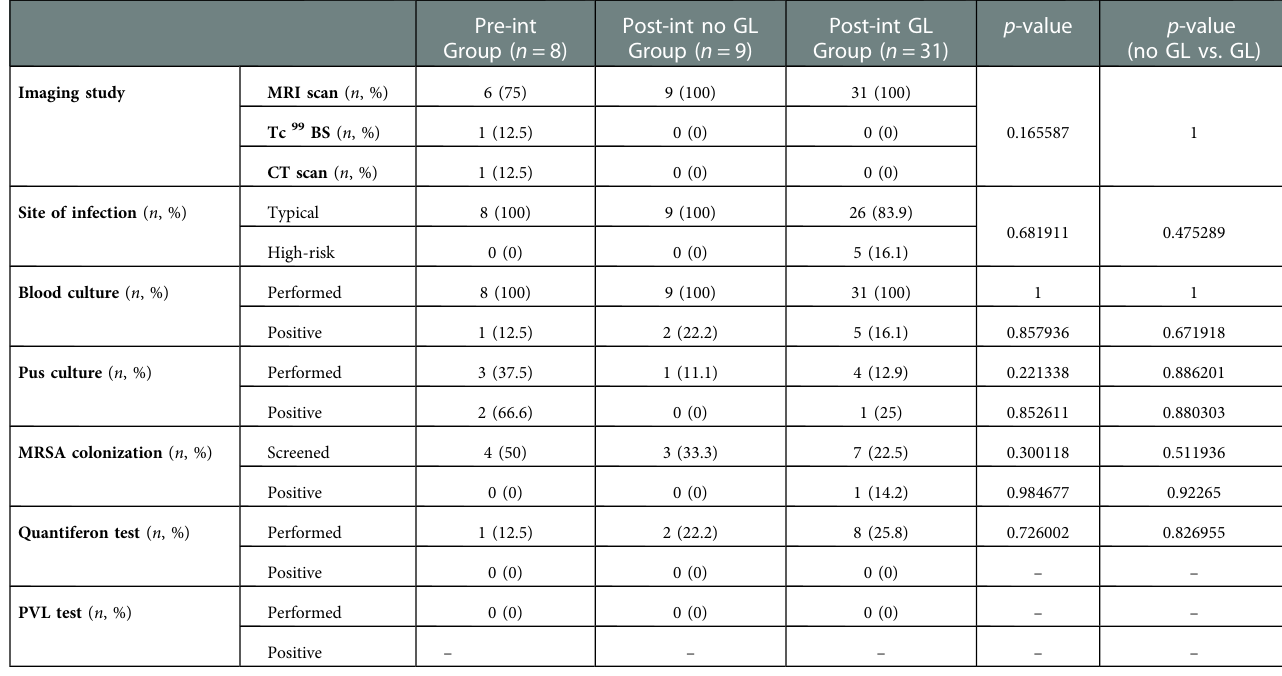
TABLE 2 Diagnostic tests -